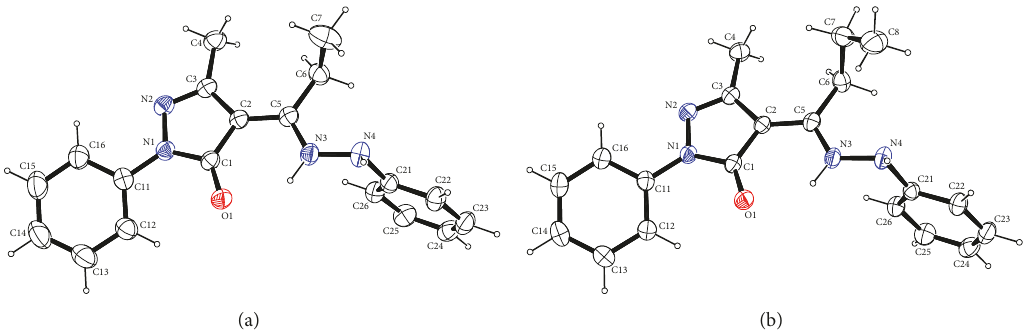
Figure 5: Ortep diagrams of (a) Empp-Ph single crystal and (b) Prmpp-Ph single crystal with ellipsoids, drawn at 50% probability